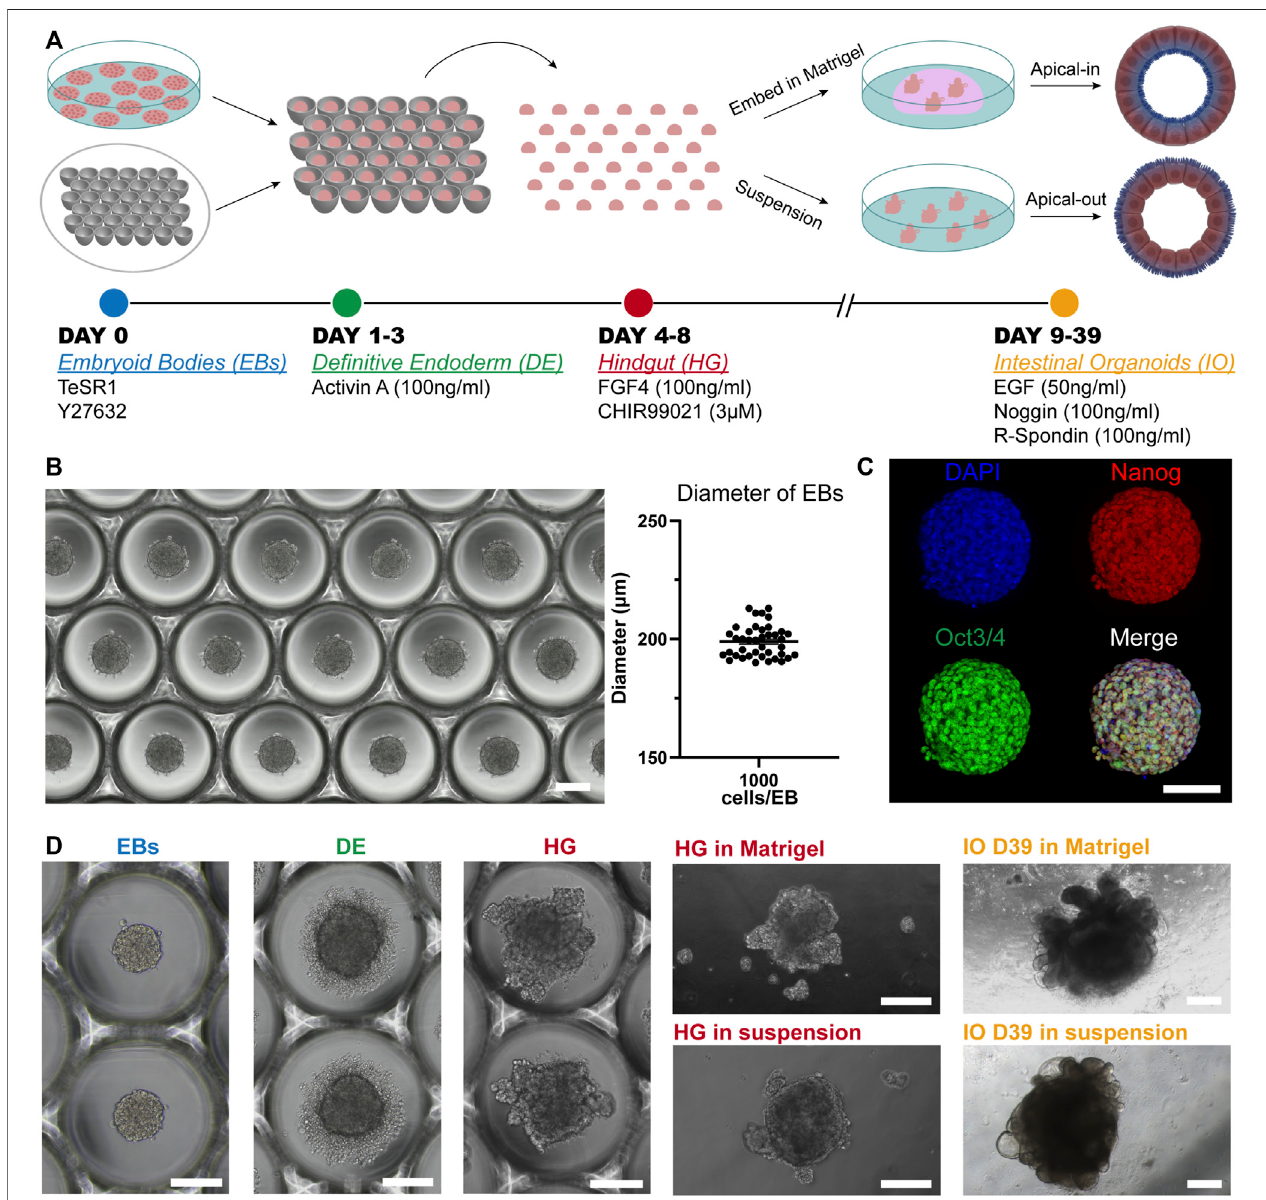
FIGURE 1 | Overview of the in vitro culture system established for the directed differentiation of EBs towards intestinal organoids. (A) Schematic representation of the protocol. (B) Formation of EBs in thermoformed microwell arrays. The graph represents the diameter of EBs 24 h after the cell seeding. Each point displays an individualEB;horizontallineanderrorbarindicatemean±S.E.M.( n =3).Scalebar:200 μ m. (C) FluorescencemicroscopyimagesofundifferentiatedEBsstainedforthe pluripotency markers Oct3/4 (green) and Nanog(red) and counterstained with DAPI(blue). Scalebar: 100 μ m. (D) Bright- fi eld images representative ofeach stage of the differentiation. Scale bars: 200 μ